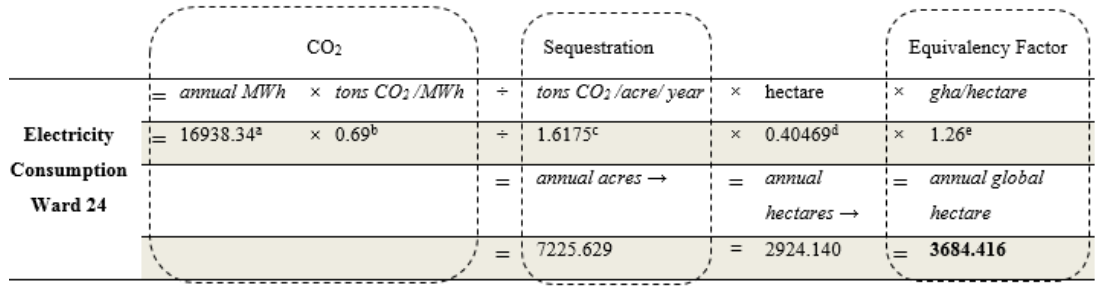
Figure 5. Electricity consumption footprint calculation and derivation. Source: a Household Survey of Ward 24 Residential Area (2015); [54]; b [55]; c [56]; d [57]; e [46].